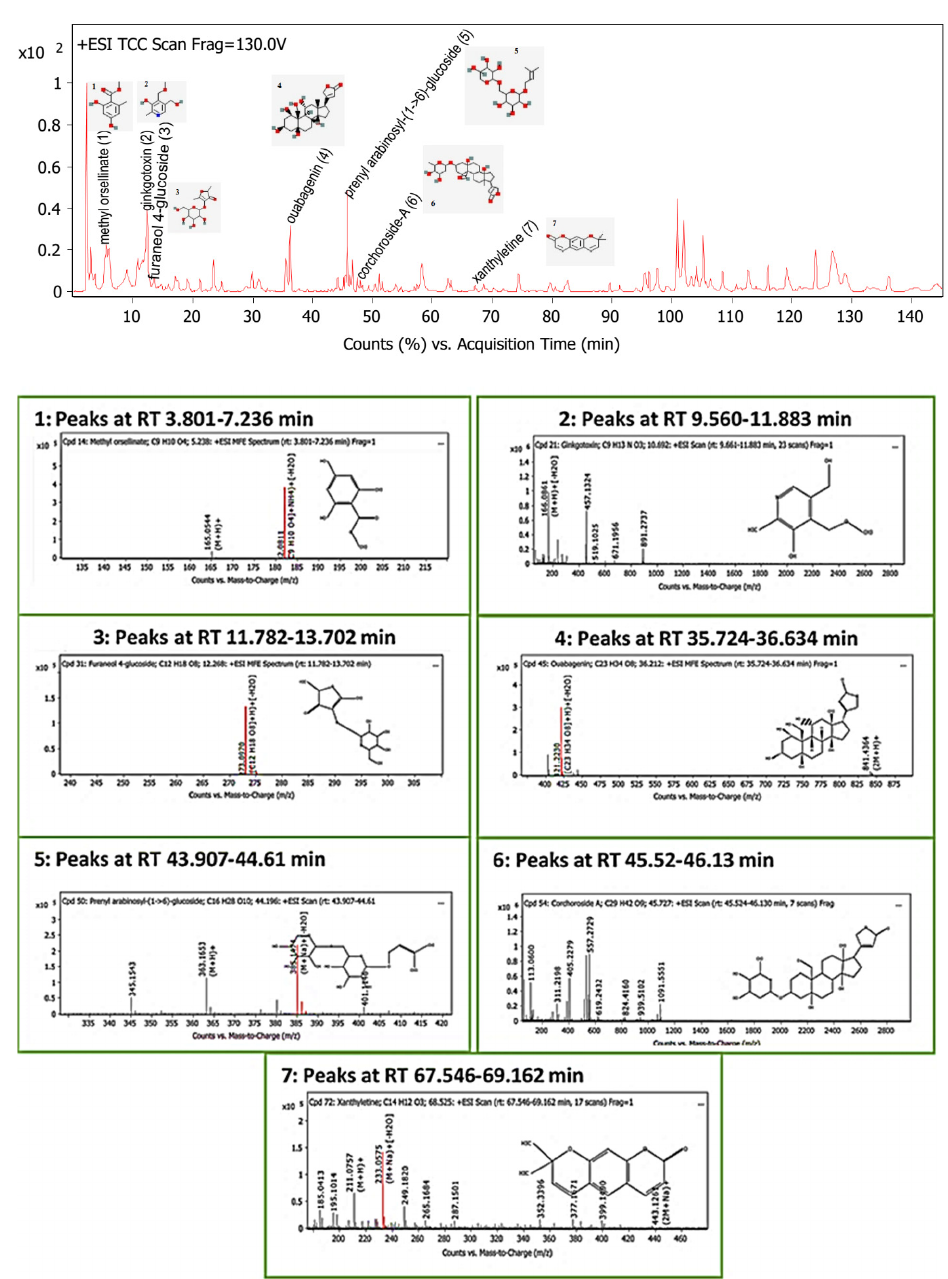
Figure 5. Base peak chromatogram of the identified bioactive metabolites in P. tomentosa L. latex: methyl orsellinate ( 1 ), ginkgotoxin ( 2 ), furaneol 4-glucoside ( 3 ), ouabagenin ( 4 ), prenyl arabinosyl-(1- >6)-glucoside ( 5 ), corchoroside-A ( 6 ), and xanthyletine ( 7